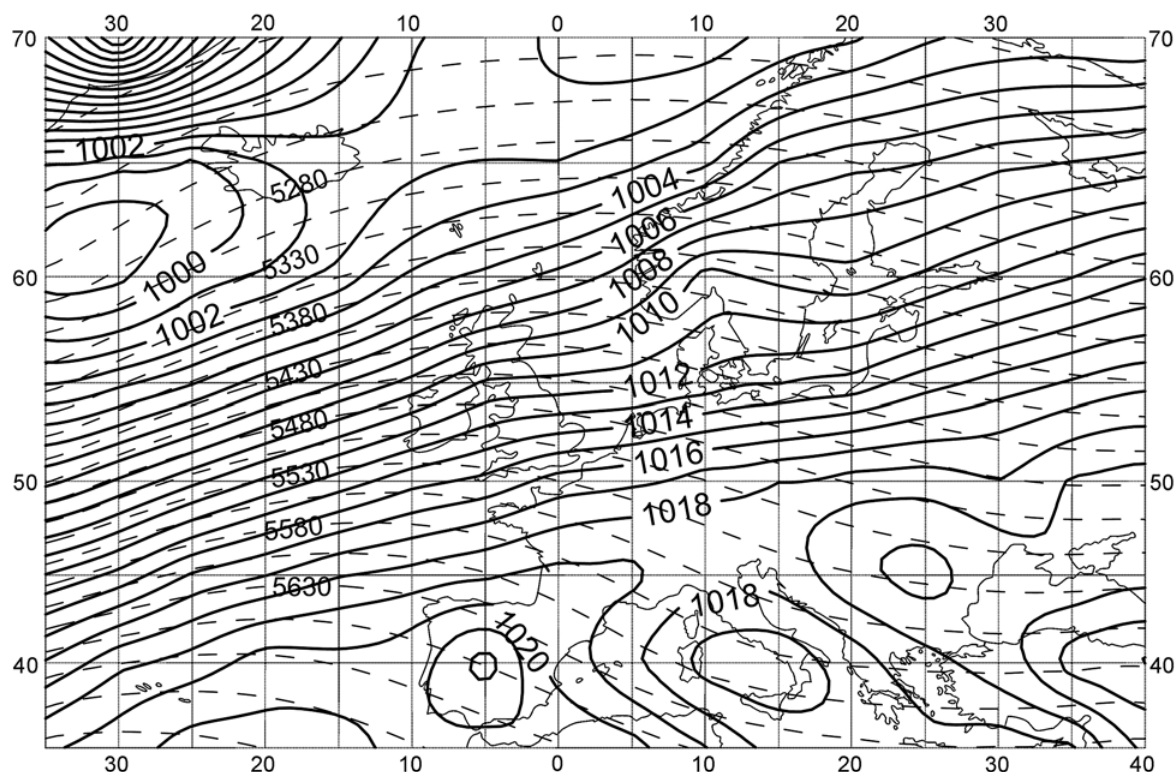
Fig. 6. Mean sLP (in hPa) and z500 hPa (in gpm) in december between 1966 and